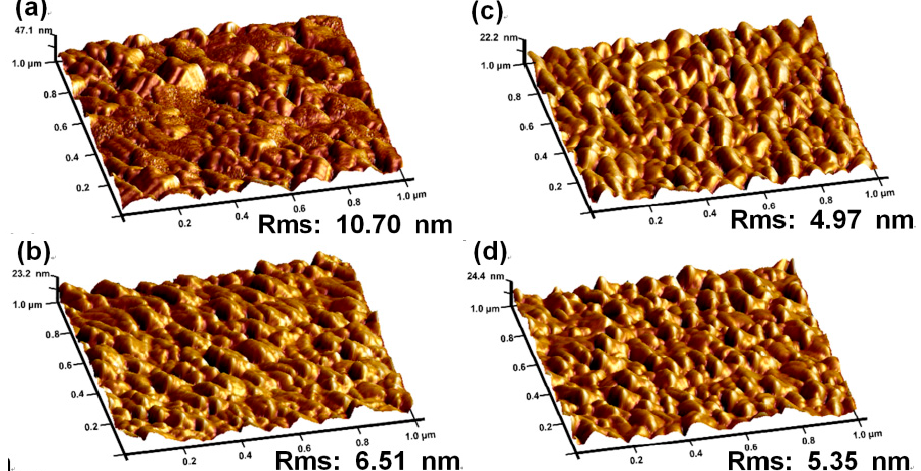
Figure 3. Atomic force microscopy (AFM) images of ( a ) and ( b ), the as-deposited Y 2 O 3 films before and after fluorocarbon plasma etching, respectively, and ( c ) and ( d ), the SF 6 plasma-treated films before and after fluorocarbon plasma etching, respectively.